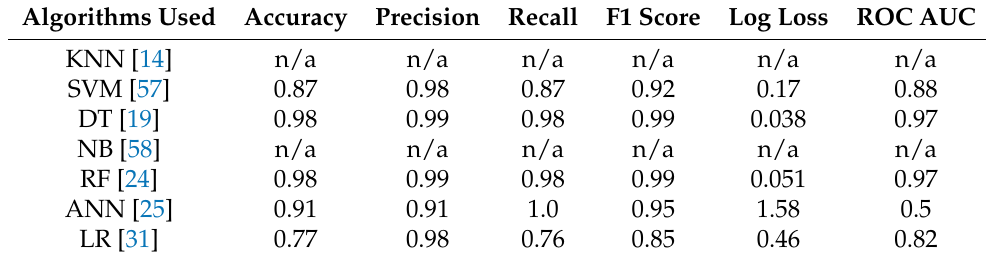
Table 24. Key logging weighted classes results.